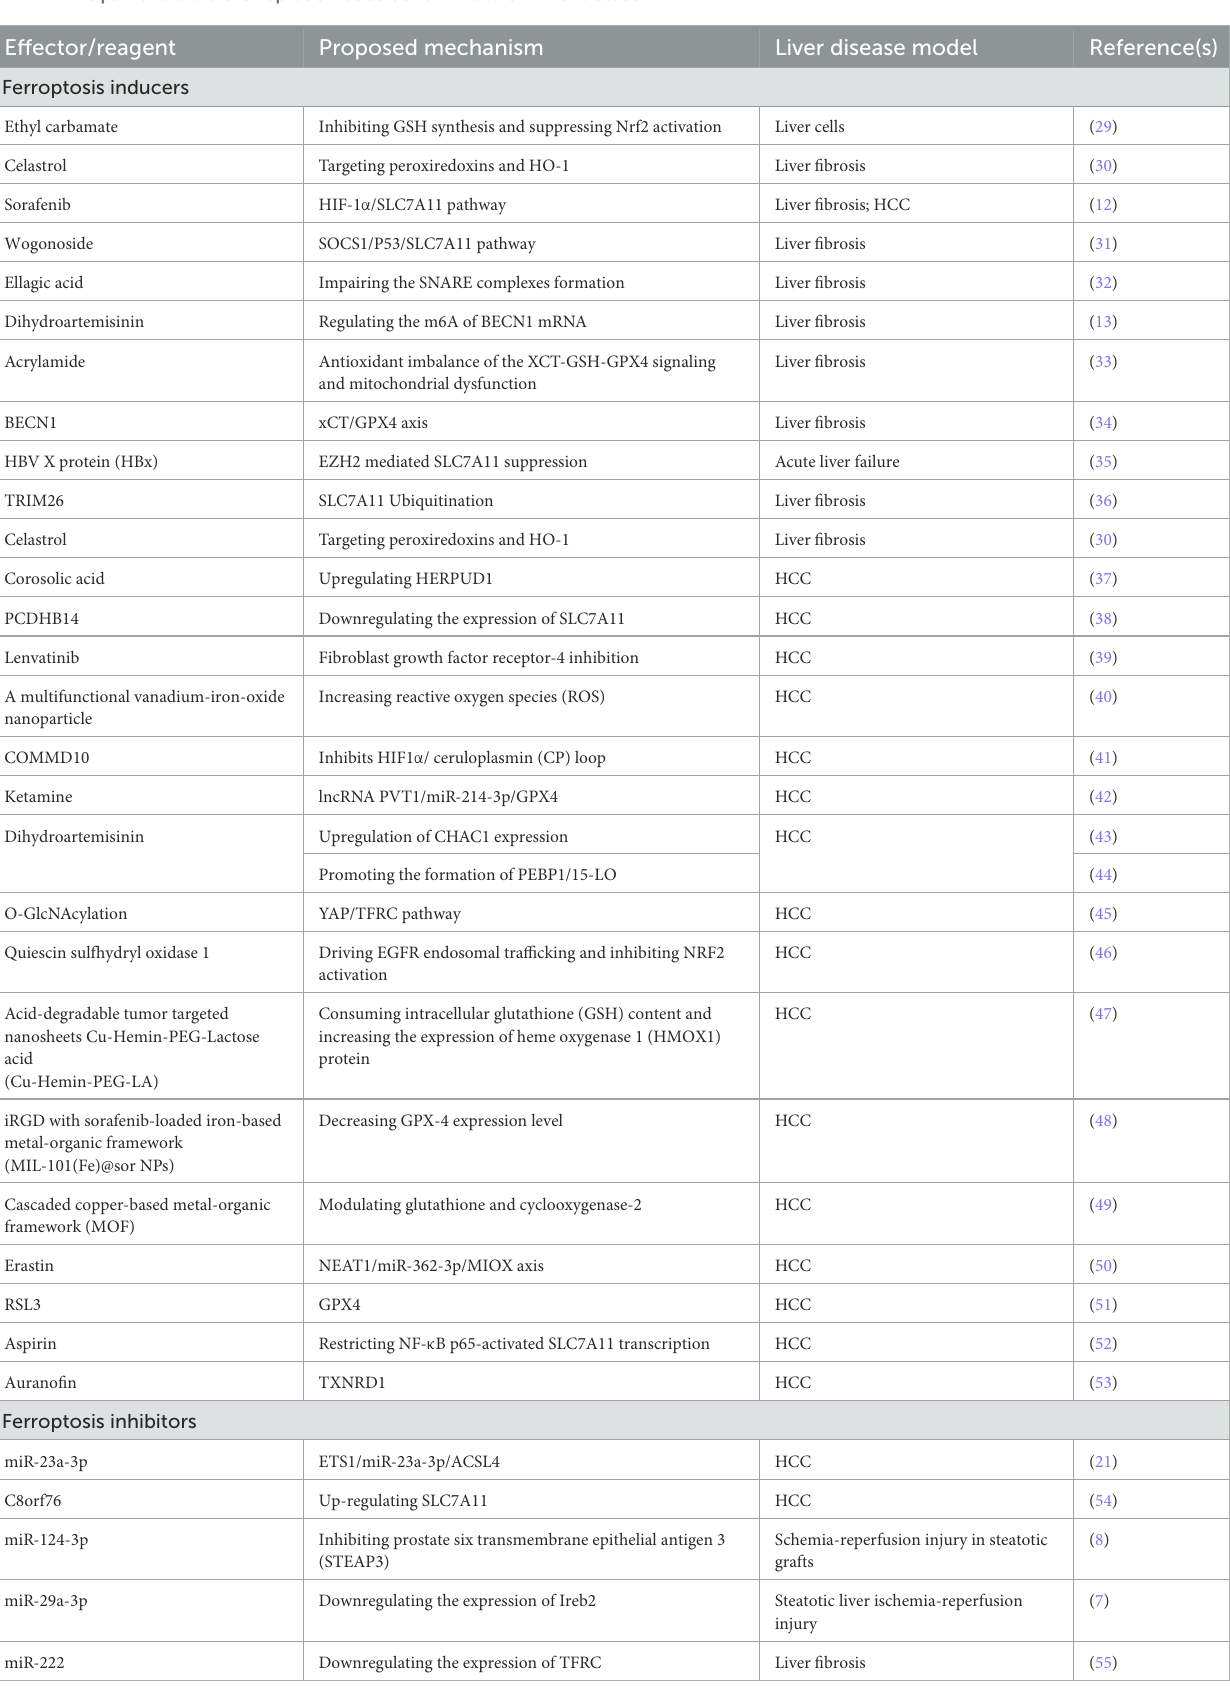
TABLE 1 The part of available ferroptosis inducers and inhibitors in liver